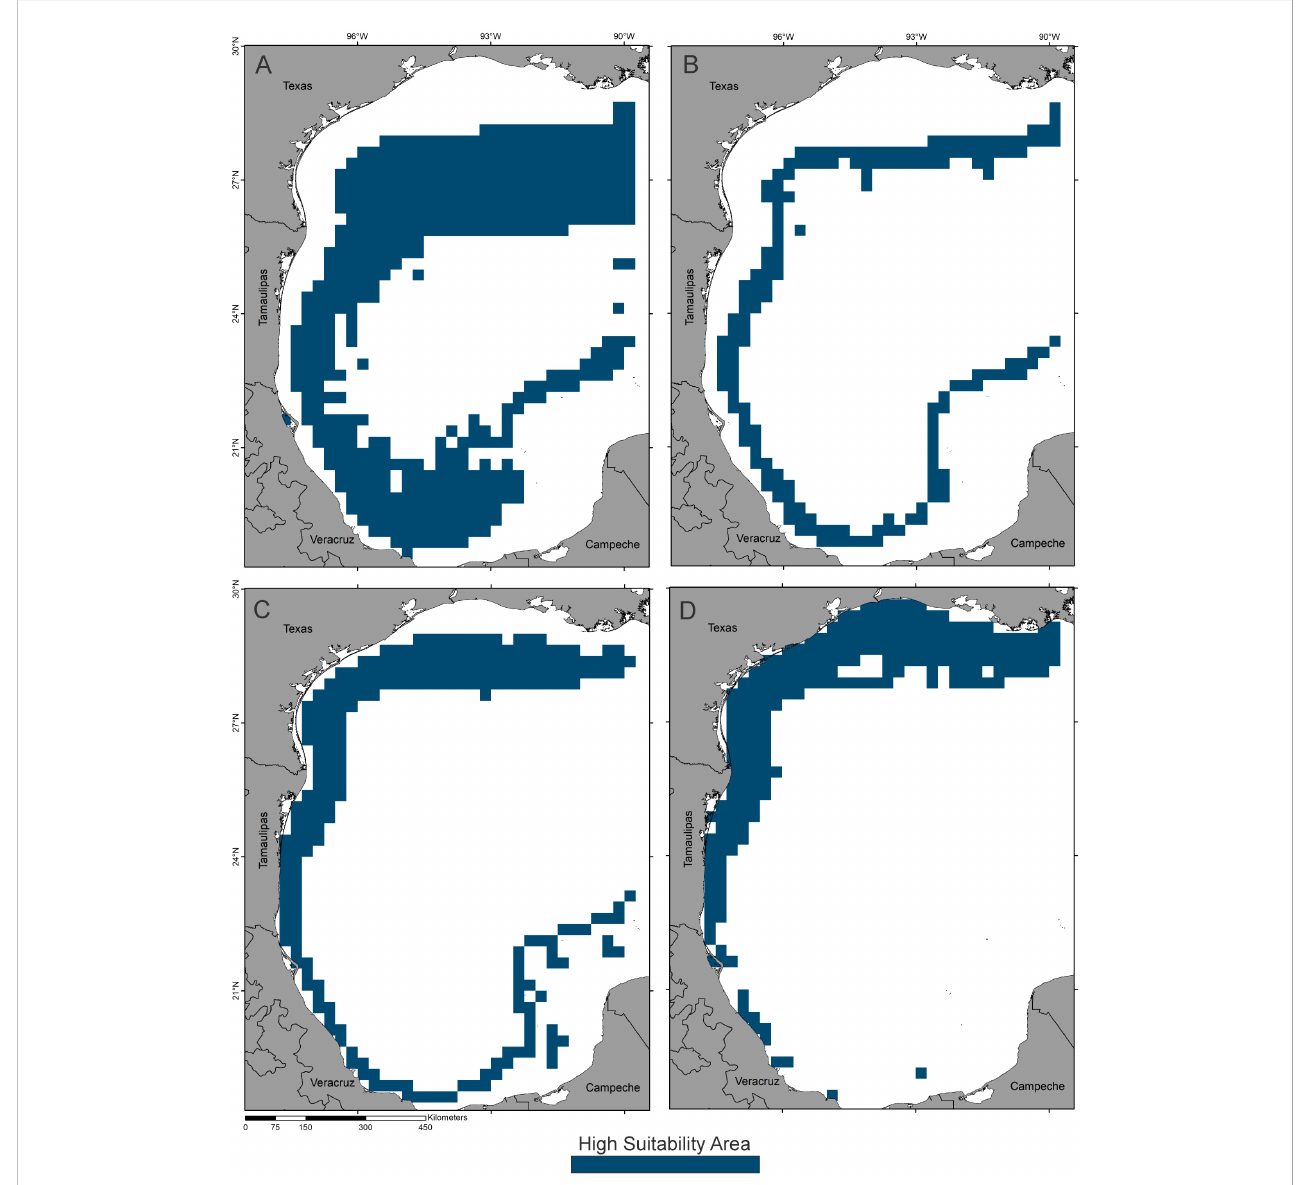
FIGURE 3 High suitability areas (in blue) in the western Gulf of Mexico for the pantropical spotted dolphin (A) , short- fi nned pilot whale (B) , Atlantic spotted dolphin (C) , and bottlenose dolphin (D) . Based on Ram ı ́ rez-Leo ́ n et al.